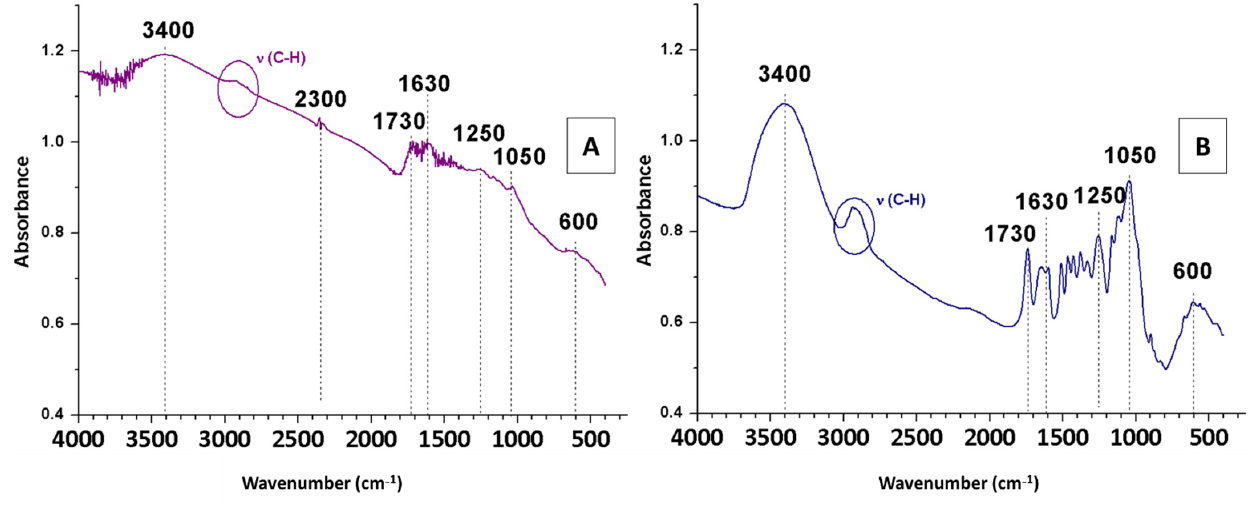
Figure 2. FTIR spectra of OS + H 2 SO 4 ( A ) and OS ( B ).